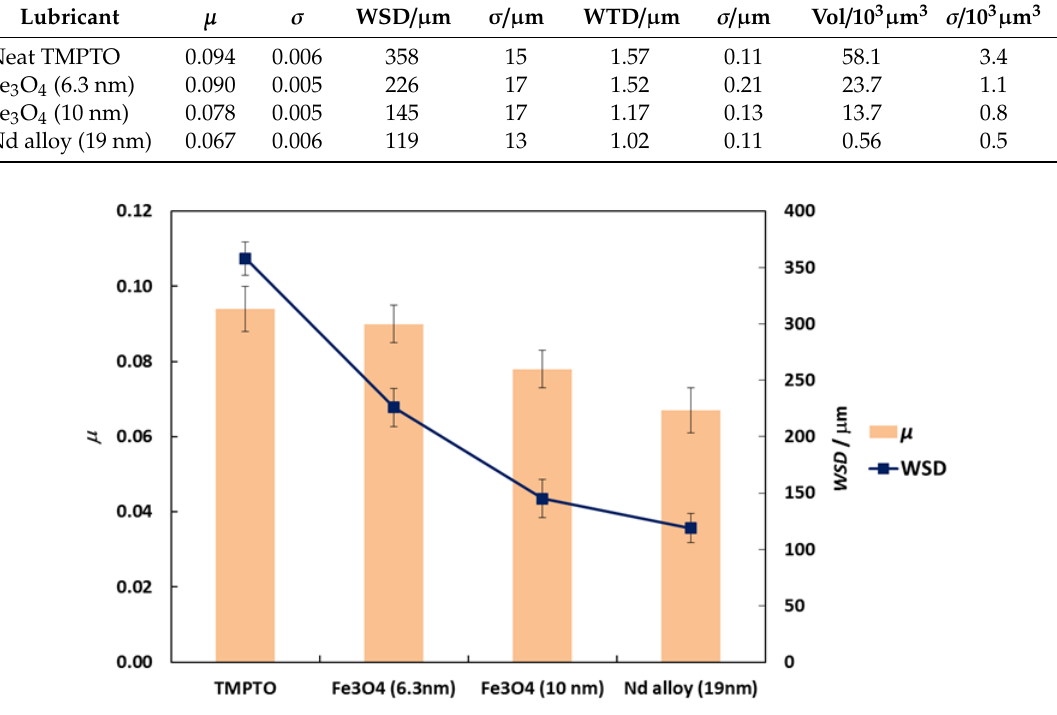
Figure 9. Friction coefficient, μ , ( ■ ) and WSD, ( ■ ) obtained with the neat oil TMPTO and with the three nanolubricants with 0.015 wt% of each NP. Error bars indicate the standard deviation of the mean friction coefficient or of the WSD.